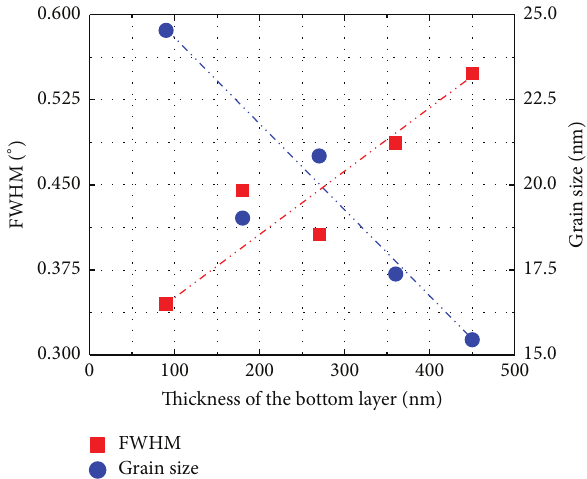
Figure 4: FWHM and grain size of bilayer Mo films as a function of the bottom layer